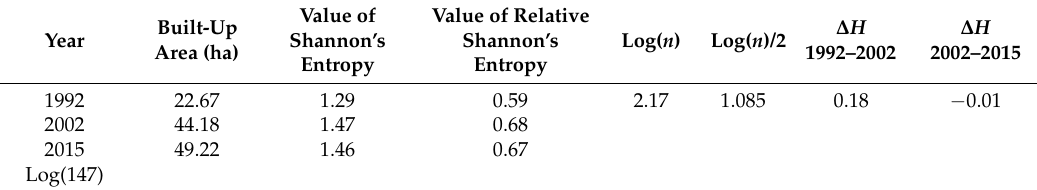
Table 8. Shannon’s entropy values for three years in the study area (MMFR buffer